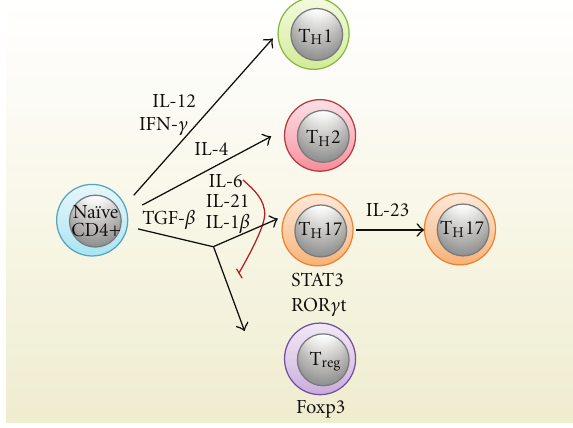
Figure 1: Polarization of T helper (T H ) cell subsets. Na¨ıve CD4+ T cells develop into di ff erent lineages (T H 1, T H 2, T H 17, and T reg ) in response to cytokine cues produced from antigen presenting cells. IL: interleukin; interferon γ : IFN- γ ; FOXP3: forkhead box P3; ROR γ t: retinoic acid-related orphan receptor γ t; STAT: signal transducer and activator of transcription; β : TGF- β transforming growth